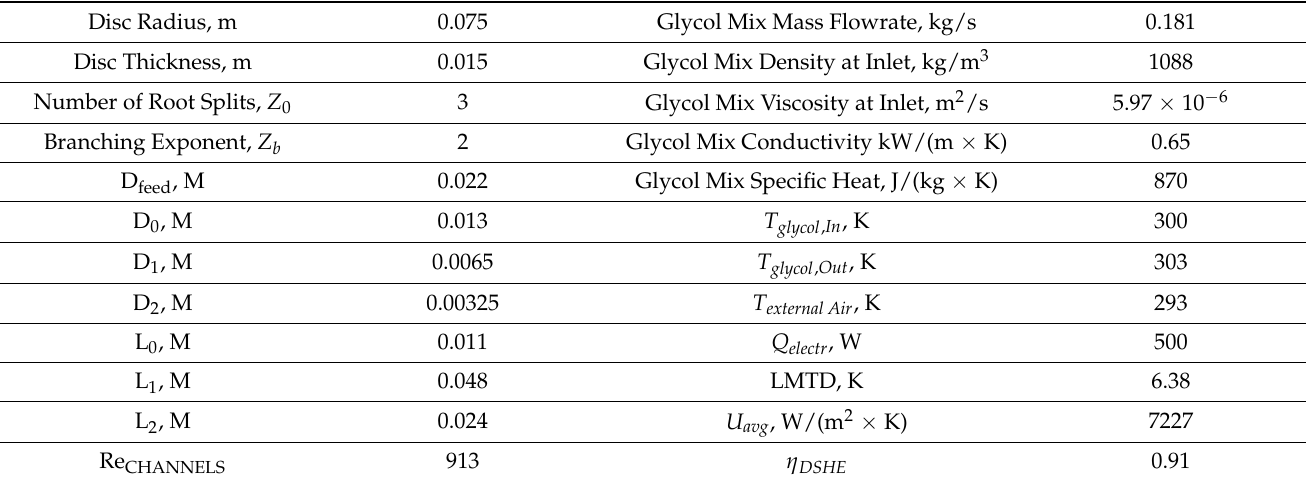
Table 2. An Al/Mn alloy DSHE cooled by a glycol/water mixture (Data adapted from [3]).